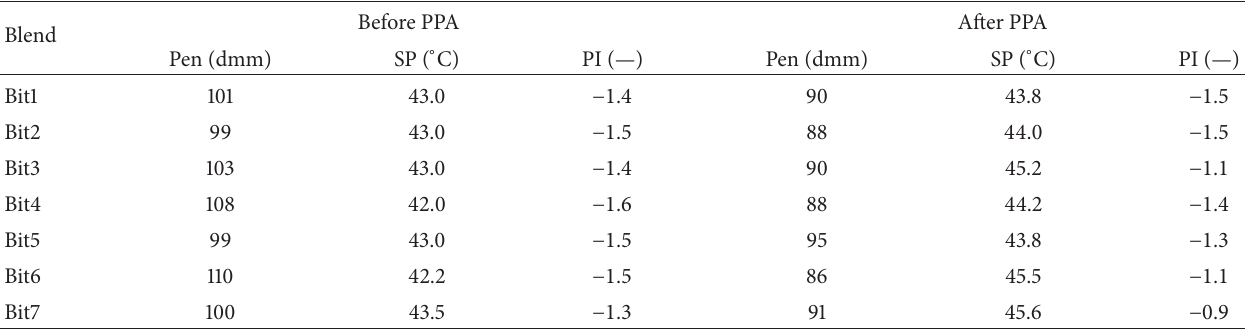
Table 4: Characteristic properties of bitumen blends, before and after PPA modification.